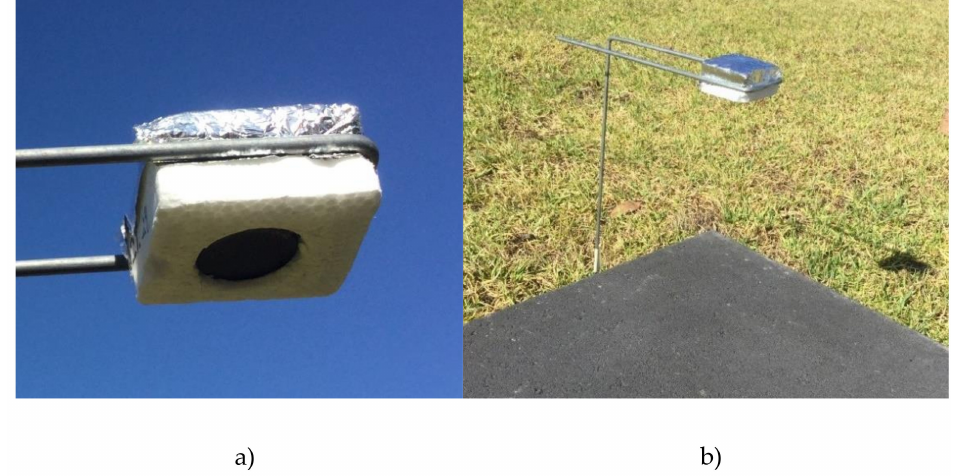
Figure 3. iButtons during measurements: ( a ) black painted iButton in a polystyrene block; and ( b ) iButton in a polystyrene block covered in aluminium foil, measuring above the grey pavers